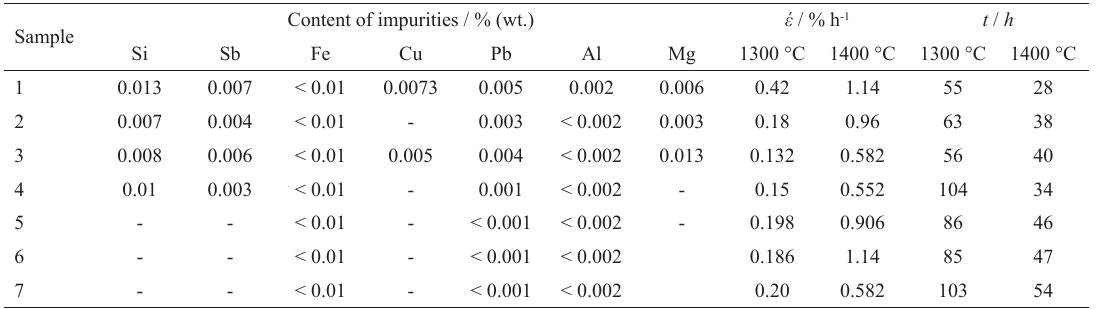
Table 2: Characteristics of high-temperature resistance of alloy PtRh7 depending on impurity content at 1300 and 1400 °C and stress of 5 MPa Content of impurities / % (wt.) Sample